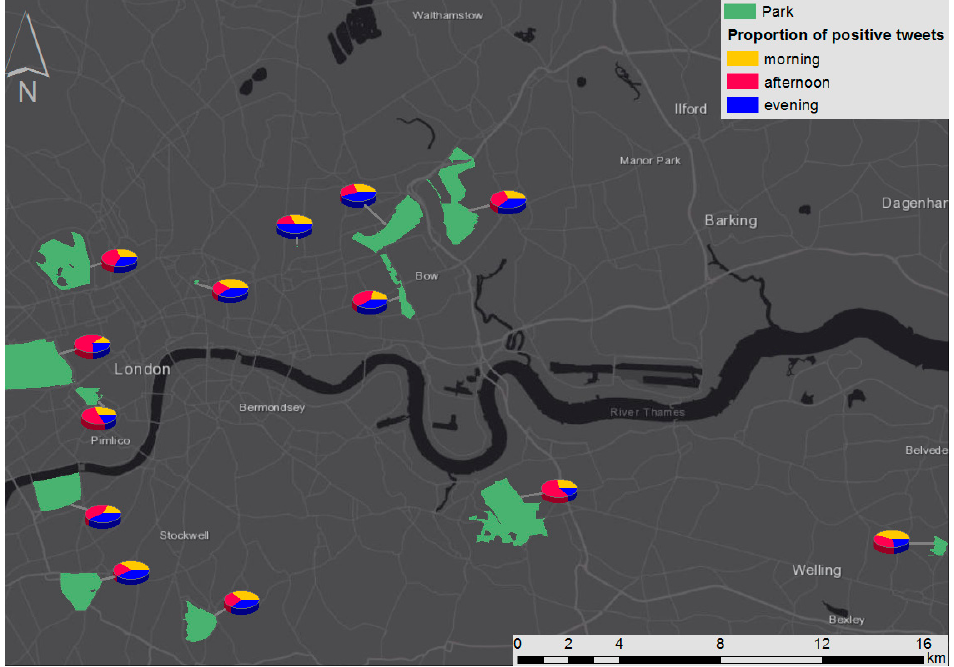
Figure 15. Proportion of positive tweets during the day on weekdays.